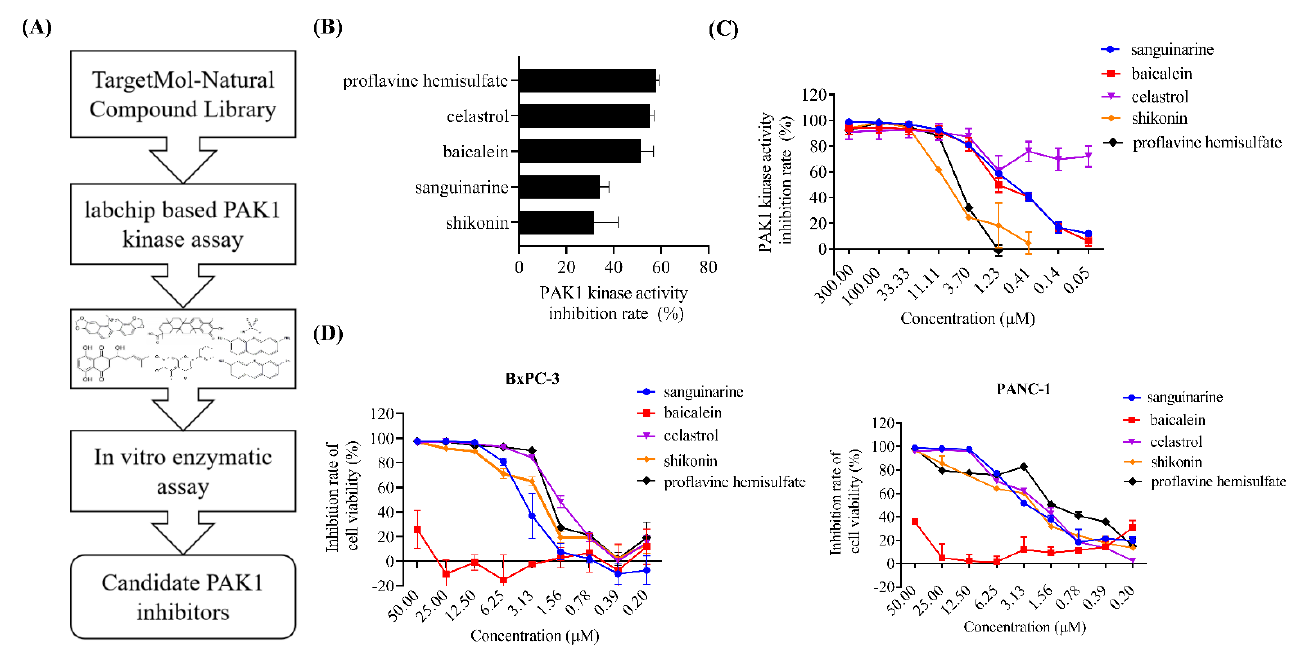
Figure 1. Screening of PAK1 inhibitors. ( A ) Process for screening PAK1 inhibitors from natural compound library. ( B ) Human PAK1 protein was incubated with indicated compounds at 5 µ M and analyzed using labchip − based PAK1 assay. ( C ) Human PAK1 protein was incubated with indicated compounds and analyzed using ADP − Glo TM kinase assay kit. ( D ) BxPC − 3 and PANC − 1 cells were treated with indicated compounds for 48 h and analyzed using MTT assay. Results are means ± SD of three independent experiments.